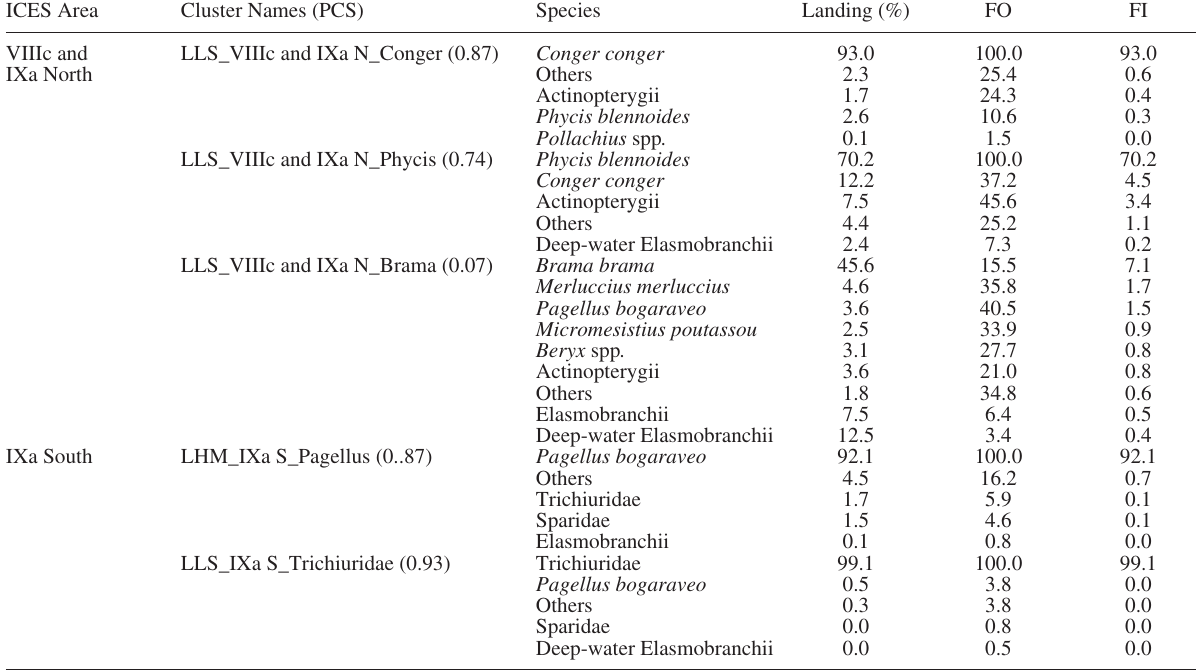
Table 5. – Catch profile (percentage in weight, frequency of occurrence and feeding index) by cluster and area for longline in VIIIc, IXa North and IXa South ICES Divisions (PCS: partial coefficient silhouette). ICES Area